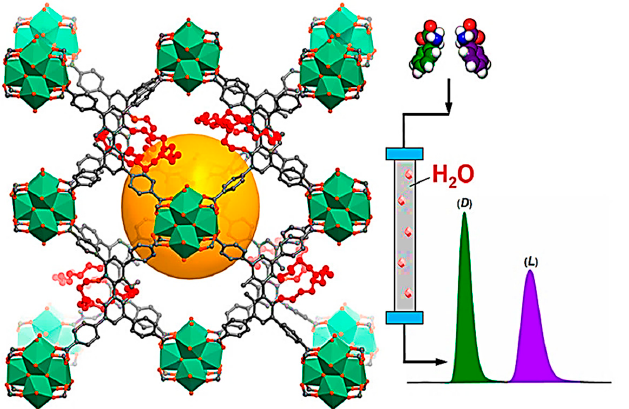
Figure 14. Enantioselective RP-HPLC separation of chiral compounds with robust Zr(IV)-based CMOFs. Reprinted (adapted) with permission from [123]. Copyright 2021 American Chemical Society.